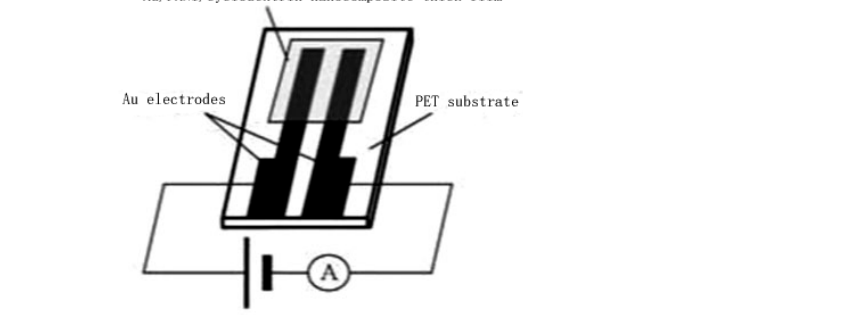
216 Figure 4. Representative SEM images of Au/PANi nanocomposite functionalized with be- 217 ta-cyclodextrin with novel interface polymerization (Sample 2) (different magnification ).